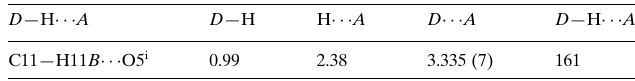
Hydrogen-bond geometry (A˚ , (cid:3)